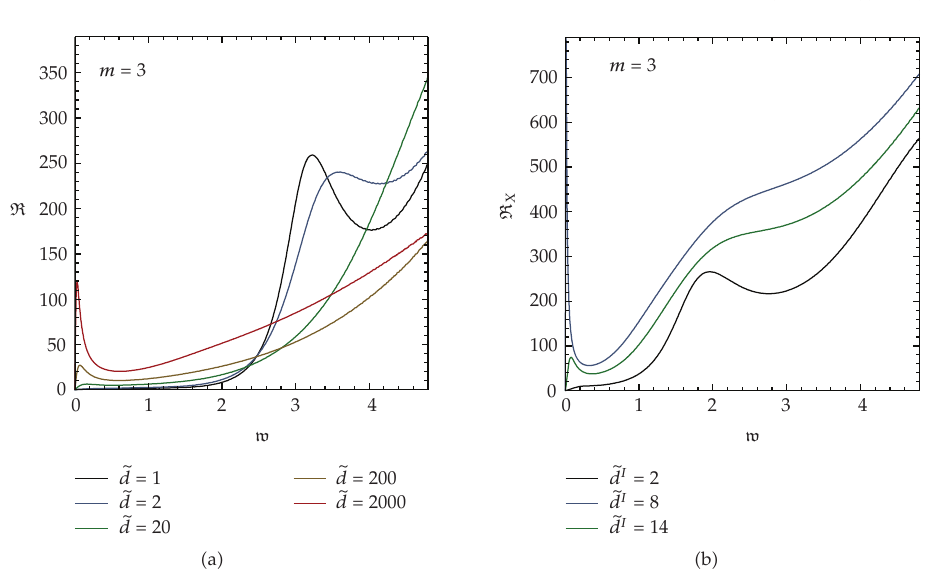
Figure 19: Spectral functions for various baryon densities (cid:2) a (cid:3) and isospin densities (cid:2) b (cid:3) , again normalized (cid:11) d the peaks are smeared out, as we saw in the discussion of the to N f N c T 2 / 4. At increasing densities spectral functions in Section 3. At very high densities a new structure forms at small w